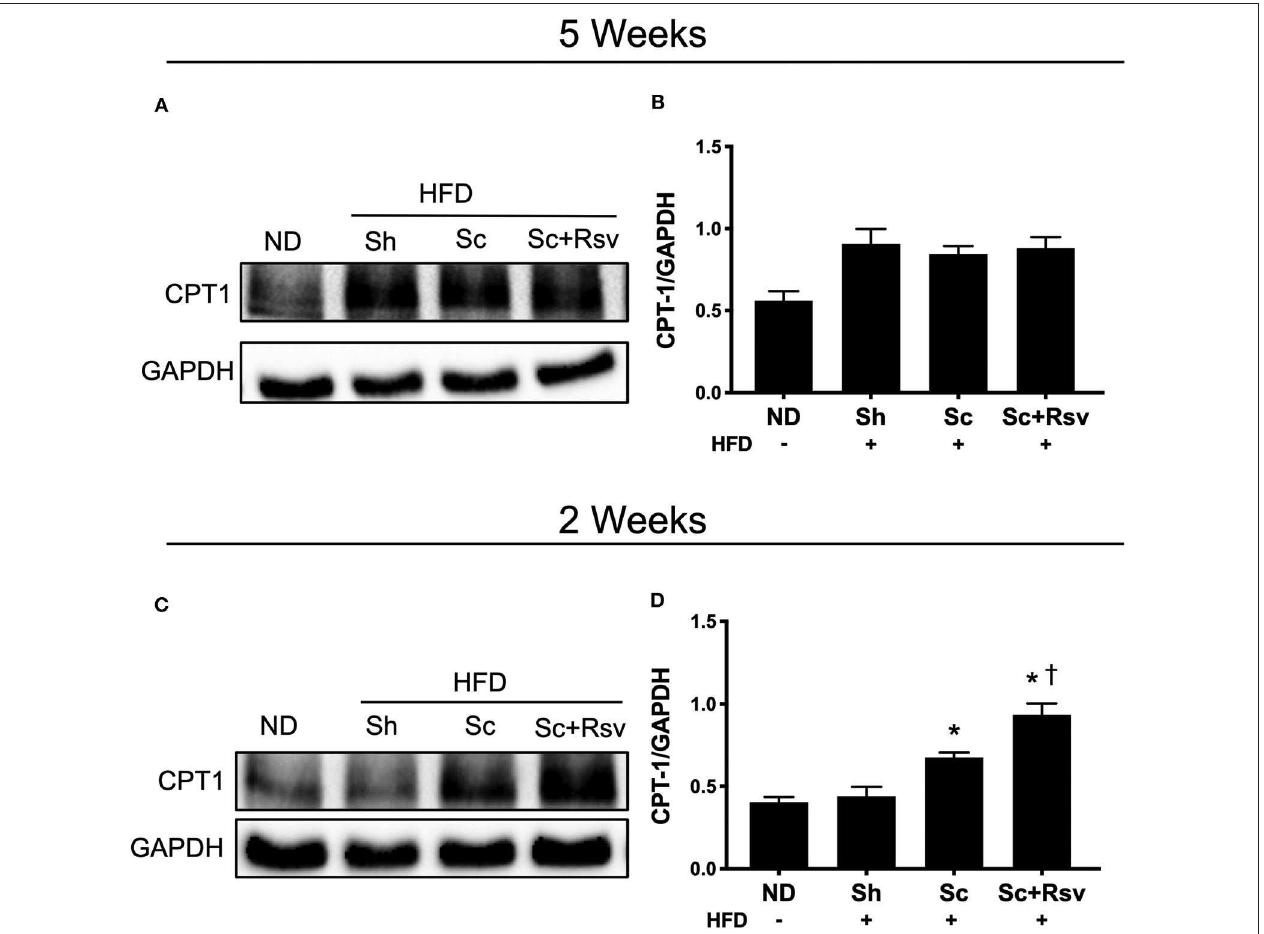
FIGURE 6 | Effect of scaffolds on CPT1A in the epididymal fat. Representative western blots and band quantification for carnitine palmitoyltransferase 1 (CPT1A) in the epididymal fat (A,B) 5 weeks and (C,D) 2 weeks after implant. Statistics were calculated by one-way ANOVA with a Tukey’s multiple comparisons test. * Represents p < 0.05 compared to HFD + Sh, † represents p < 0.05 compared to HFD + Sc. n = 5 mice per